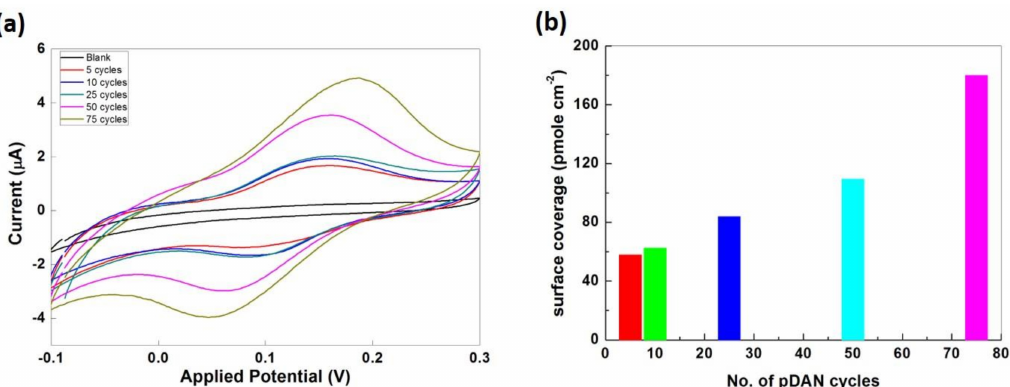
Figure 4. ( a ) Cyclic voltammogram of Ferrocene carboxylic acid functionalized CVD graphene and pDAN modified CVD graphene at different scan cycles. PBS was used as the electrolyte and the CVs were recorded at a 5 mVs − 1 scan rate. ( b ) Bar chart showing the amine surface coverage in picomole cm − 2 vs. number of pDAN scan